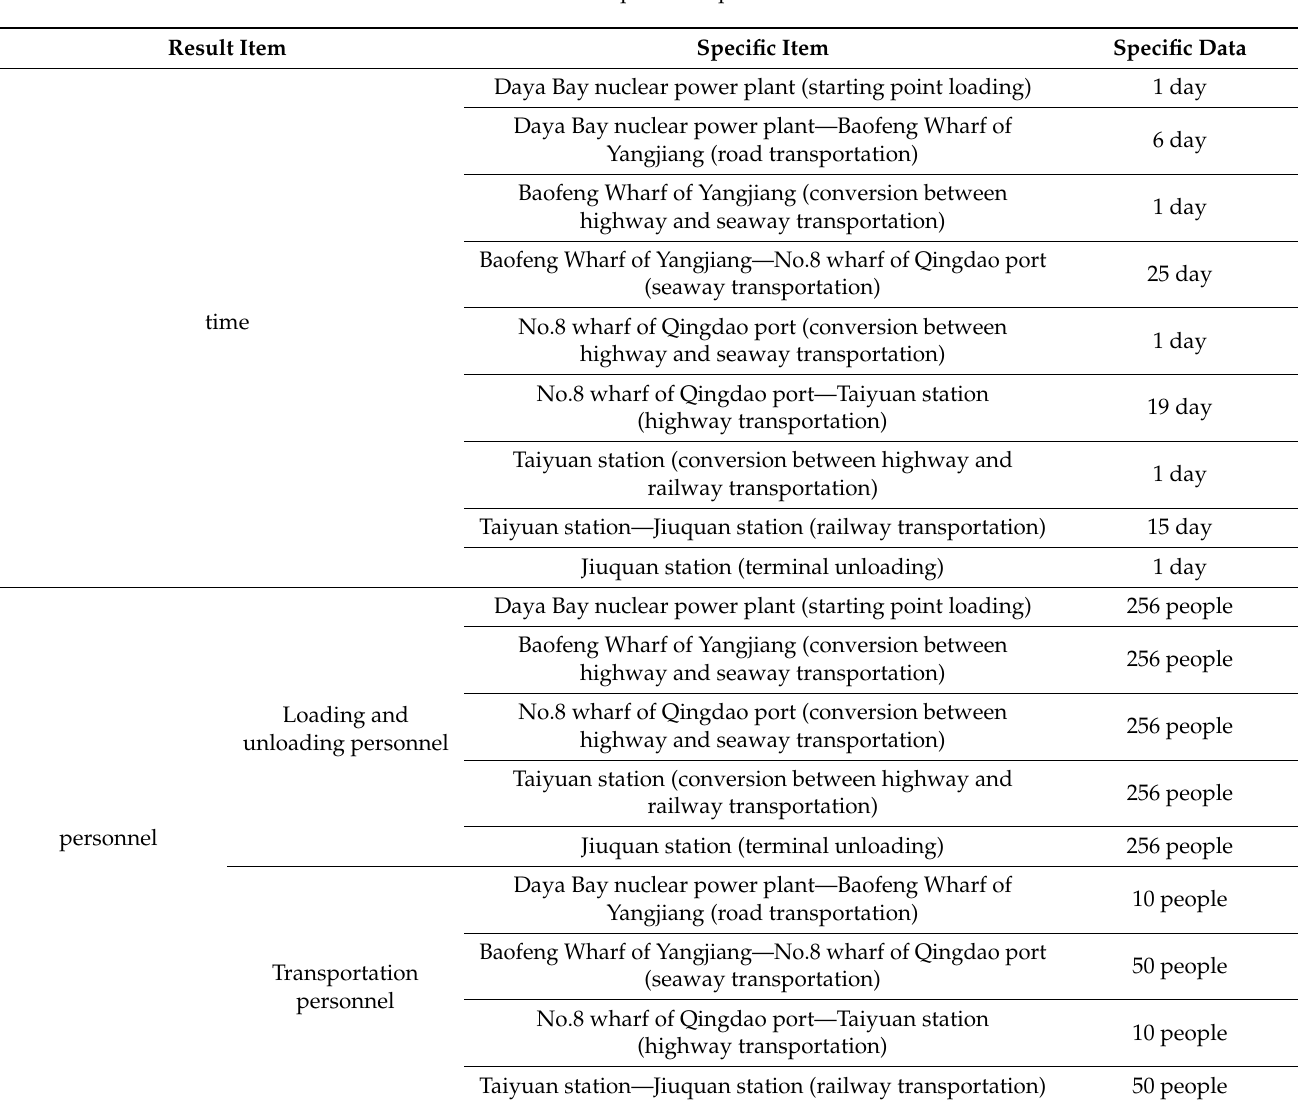
Table 3. Procedure of the transportation